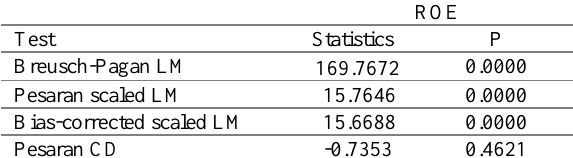
Table 13. Cross-sectional dependence test results of Model 3